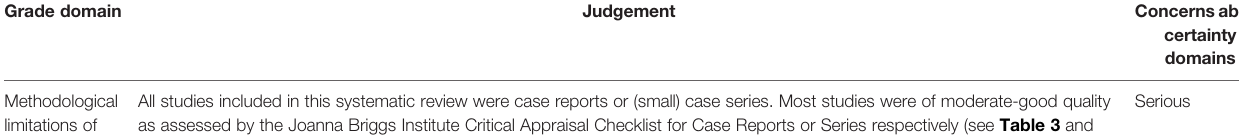
TABLE 5 | The certainty of evidence for the primary outcome, effect of treatment on the skin, rated using the Grading of Recommendations, Assessment, Development, and Evaluations (GRADE) approach by Murad et al.